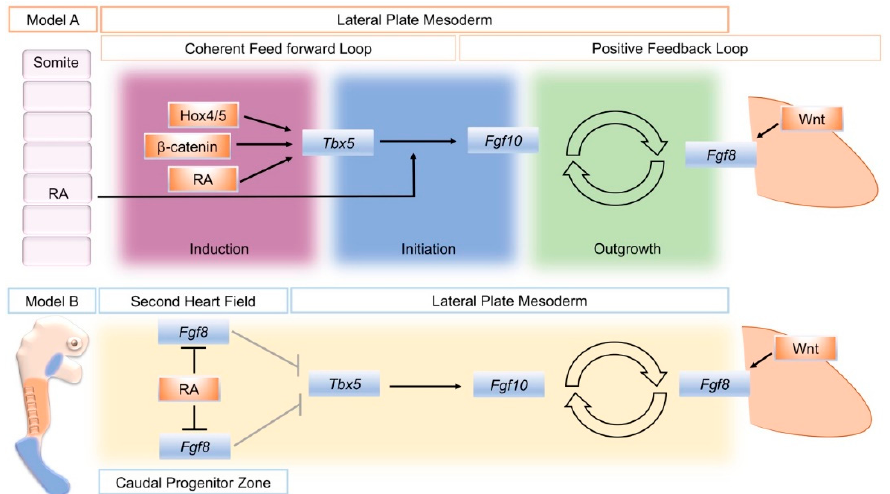
Figure 1. Schematic summary of two different models to explain the action of retinoic acid (RA) to establish the limb bud. Model A distinguishes three phases of limb bud development; induction, initiation, and outgrowth. RA, Wnt/ß-catenin signaling, and spatially restricted Hox genes combine to activate Tbx5 in a restricted region of the lateral plate mesoderm that will become the forelimb-forming region (Induction). In a coherent feed-forward loop, RA also combines with RA to activate fibroblast growth factor 10 ( Fgf10) expression in the forming limb mesenchyme (Initiation). Fgf10 then successively activates Fgf8 in the overlying ectoderm, and a positive feedback loop of FGF signaling is established that sustains limb bud outgrowth (Outgrowth). An alternative, model B: Mutual antagonism between retinoic acid (RA) and fibroblast growth factor 8 ( Fgf8 ) enables Tbx5 expression to be established in the future forelimb-forming region of the lateral plate mesoderm. At stages just prior to forelimb bud formation in the mouse, (E8.5) RA (orange) produced in the trunk region restricts Fgf8 expression (blue) to the more rostrally located, second heart field and the caudal progenitor zone, de-repressing the repressive effect of Fgf8 on Tbx5 expression (shown by gray arrows). Model A schematic is derived from [24], Figure 1. Model B is derived from [8], Figure 3.